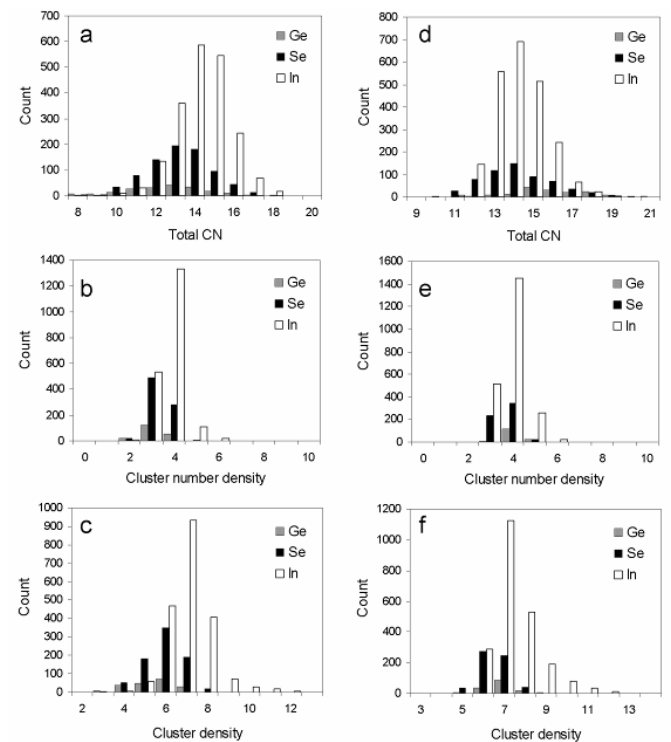
Figure 2. Particle histograms ( i.e. , number of particles in each histogram bin vs. coordination number, CN, cluster number density and mass density) within the second coordination shell of interatomic interactions. Panels ( a ) to ( c ) refer to GeSe 4 In 10 and panels ( d ) to ( f ) refer to GeSe 4 In 15 . The cluster number density values must be multiplied by 0.01 to yield units of atoms/Å 3 . Cluster density is expressed in